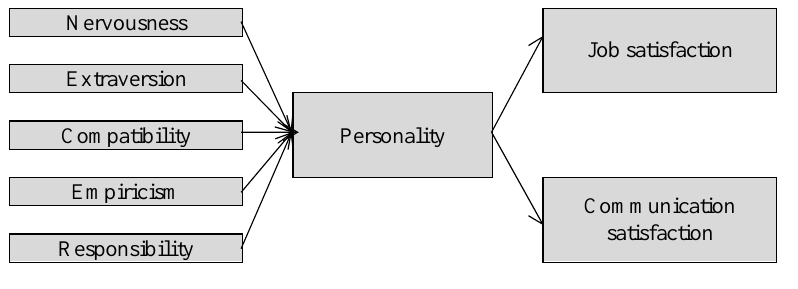
Fig. 1. The proposed